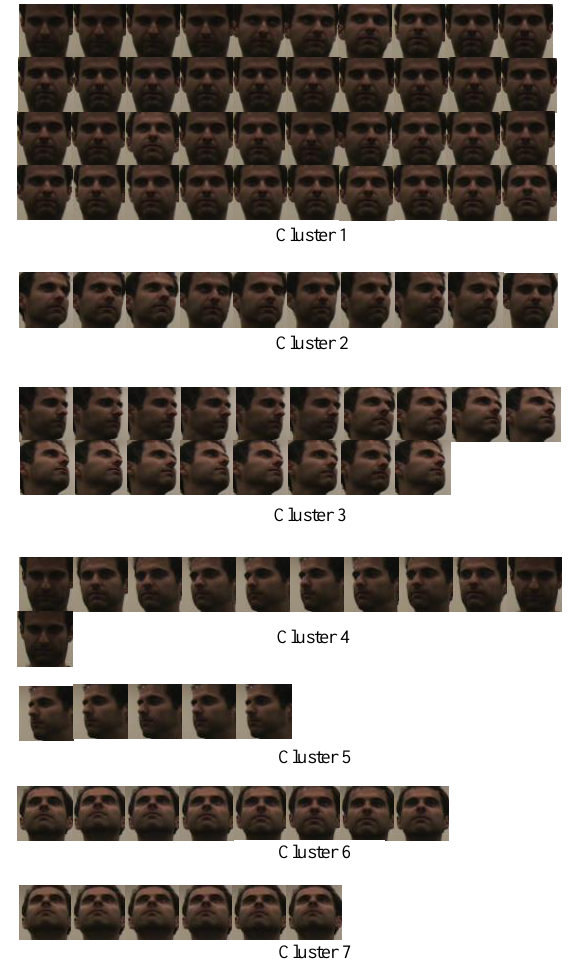
Figure 5. Clusters obtained by comparing correlation.